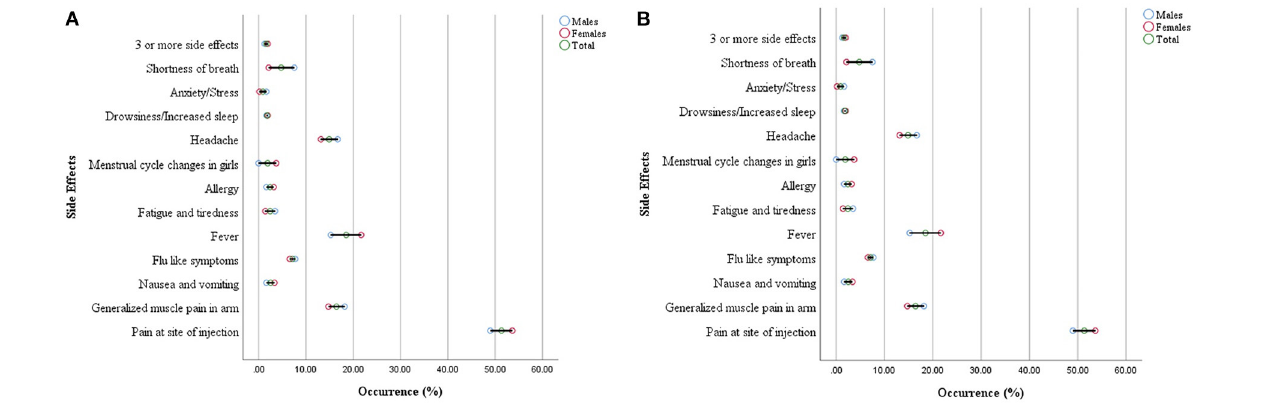
FIGURE3 Gender distribution of reported side effects after the first dose (A) and second dose (B) .